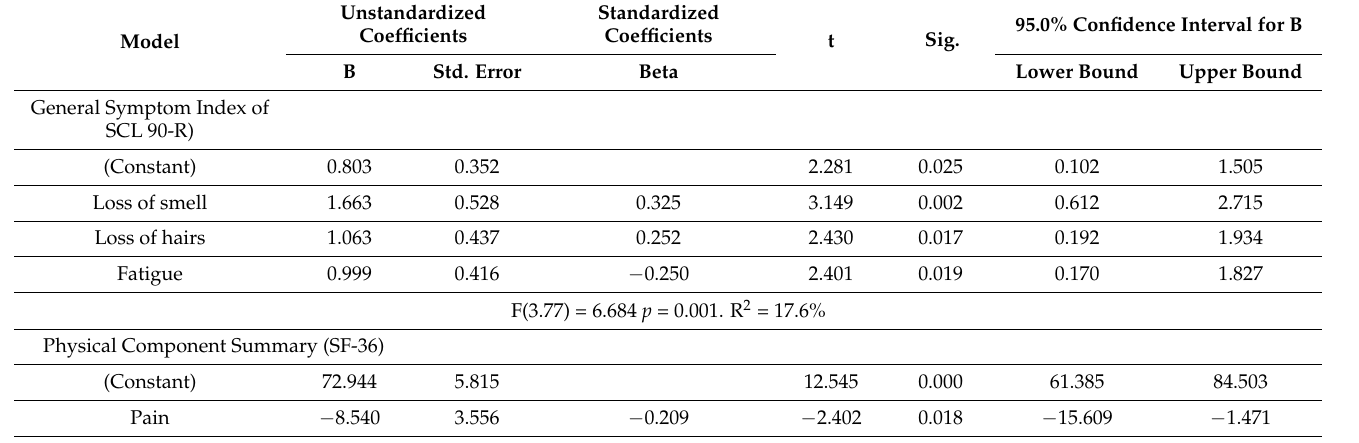
Table 5. Multivariate regression analysis using the stepwise method with dependent variable psycho- logical distress (General Symptom Index of SCL 90-R) and independent variables patient clinical and demographic characteristics ( n =